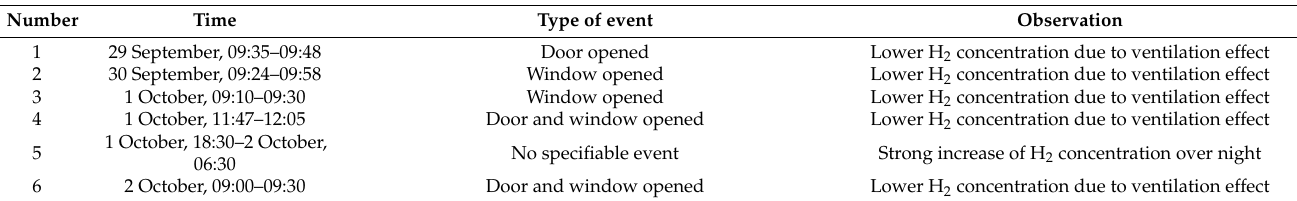
Table A1. List of all events (release tests, ventilation and other) during the field tests and the observed sensor behavior during that